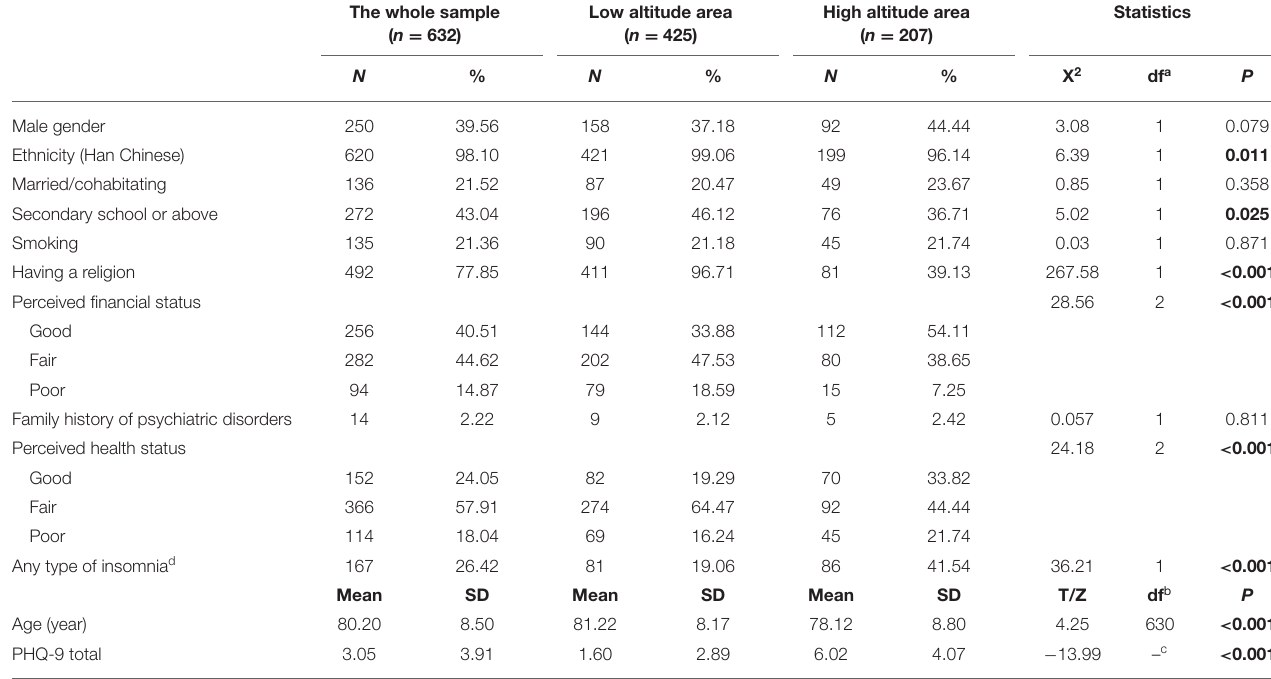
TABLE 1 | Basic demographic and clinical characteristic of the whole